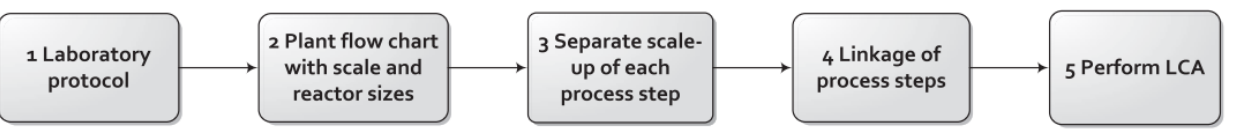
Figure 8. Schematic diagram of proposed research stage ex ante LCA of salt hydrate TCES (adapted from [58]).